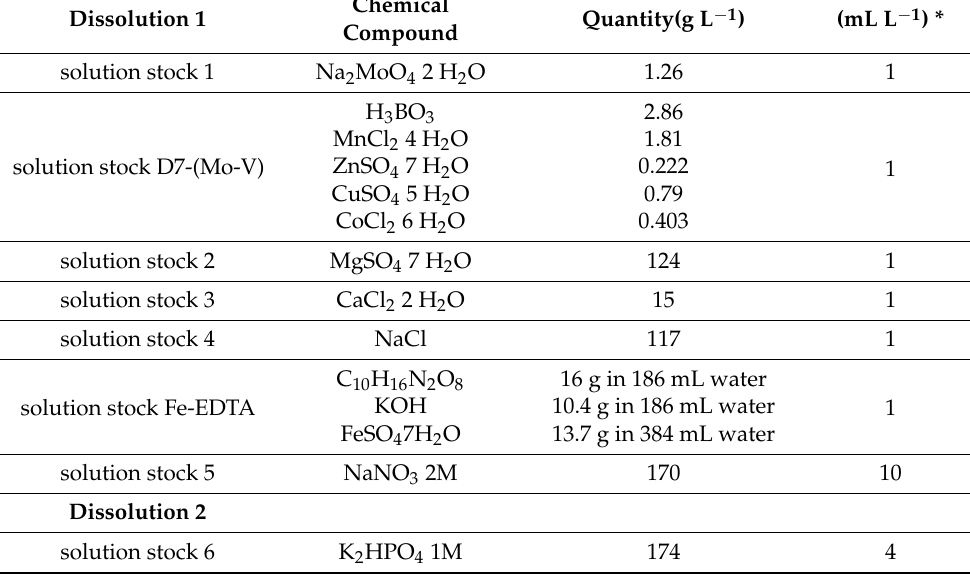
Table 1. Arnon medium